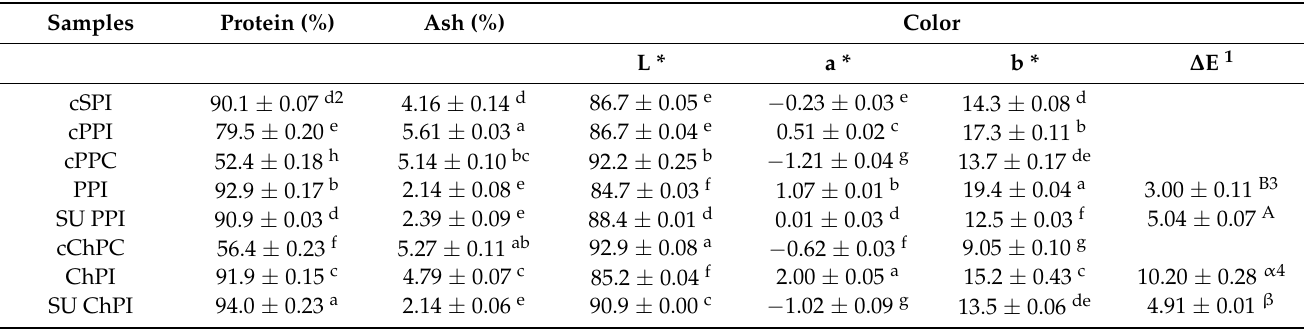
Table 1. Protein, ash, and color (L * a * b * and ∆ E) of benchtop and scaled-up pea and chickpea protein isolates (PPI, SU PPI, ChPI, and SU ChPI), as well as commercial SPI, PPI, PPC and